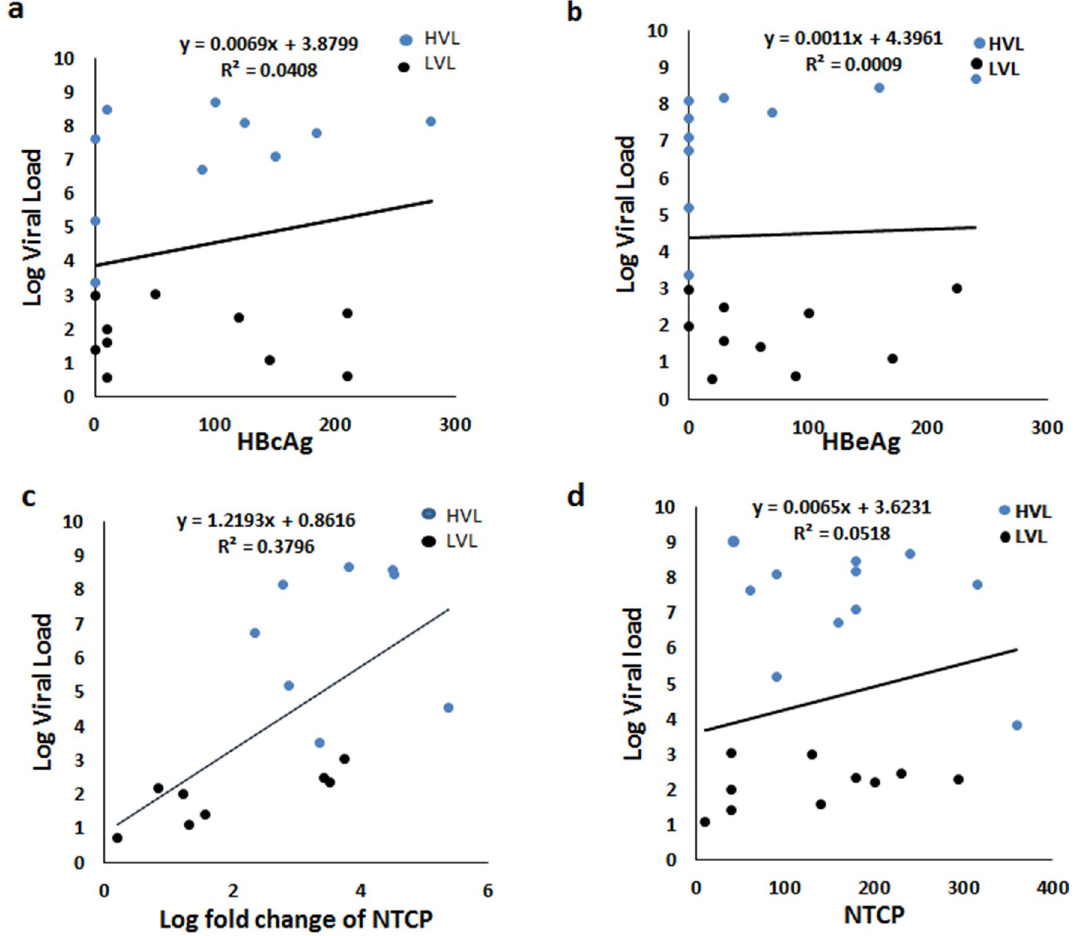
Figure 7. Dot plots showing correlation between, IHC scores of ( a ) HBcAg (PC = 0.04907, R 2 = 0.0139) ( b ) HBeAg (PC = − 0.05213, R 2 = 0.0009). ( c ) log fold change of NTCP expression (PC = 0.7118, R 2 = 0.3796, p = 0.0027) and ( d ) IHC score of NTCP (PC = 0.3577, R 2 = 0.0518) with viral load. Correlation coefficient was calculated using Spearman’s correlation test. HVL High Viral Load Group, LVL Low Viral Load